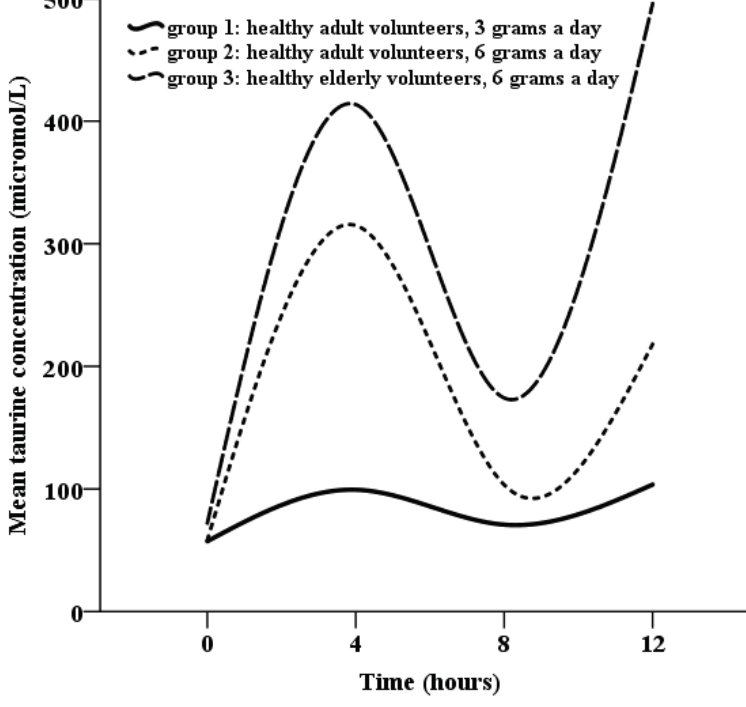
Figure A1. Results of a dose finding on taurine